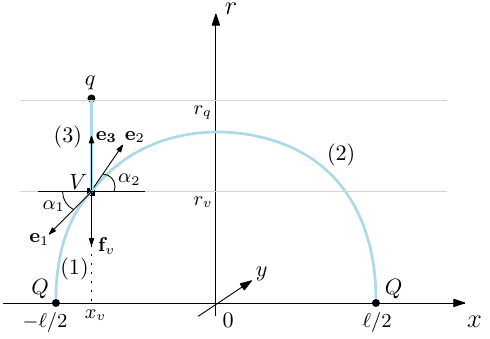
Figure 6 . A non-symmetric static configuration. The baryon vertex is located on the xr -plane at the point ( x v , r v )